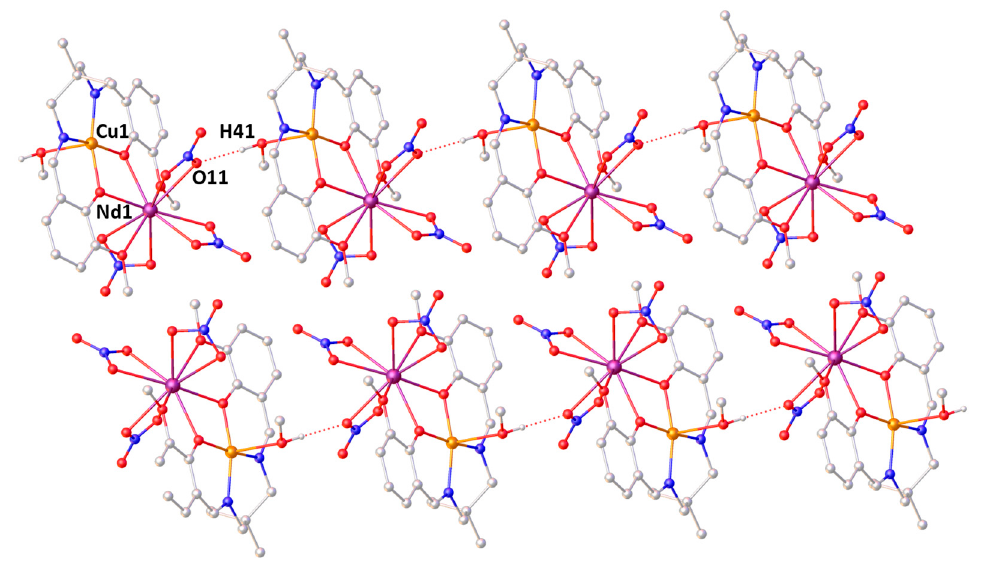
Figure 3. The dominant hydrogen-bonding interactions in 1-Nd showing the 1D chains along the a - axis. All carbon-bound hydrogen atoms are omitted for clarity.